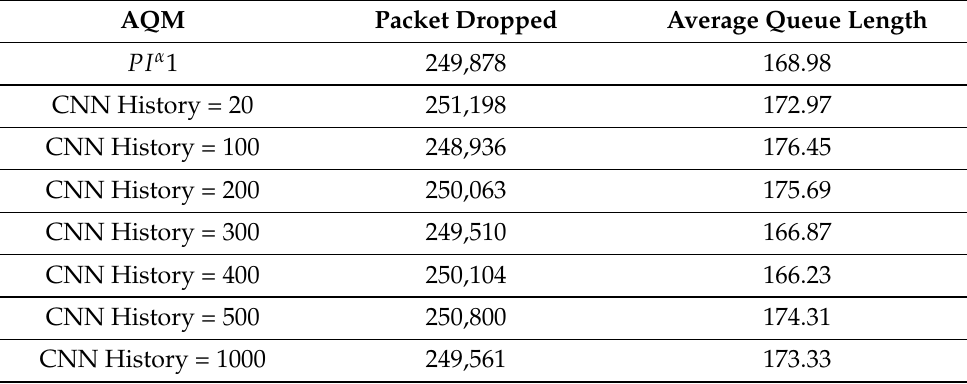
Table 6. Detailed results of queue occupancy obtained for CNN model with the last layer activation function Sigmoid, trained using data regarding PI α 1 controller and parameters: K P = 0.0001, K I = 0.0004, α = − 0.4 and H = 0.5.